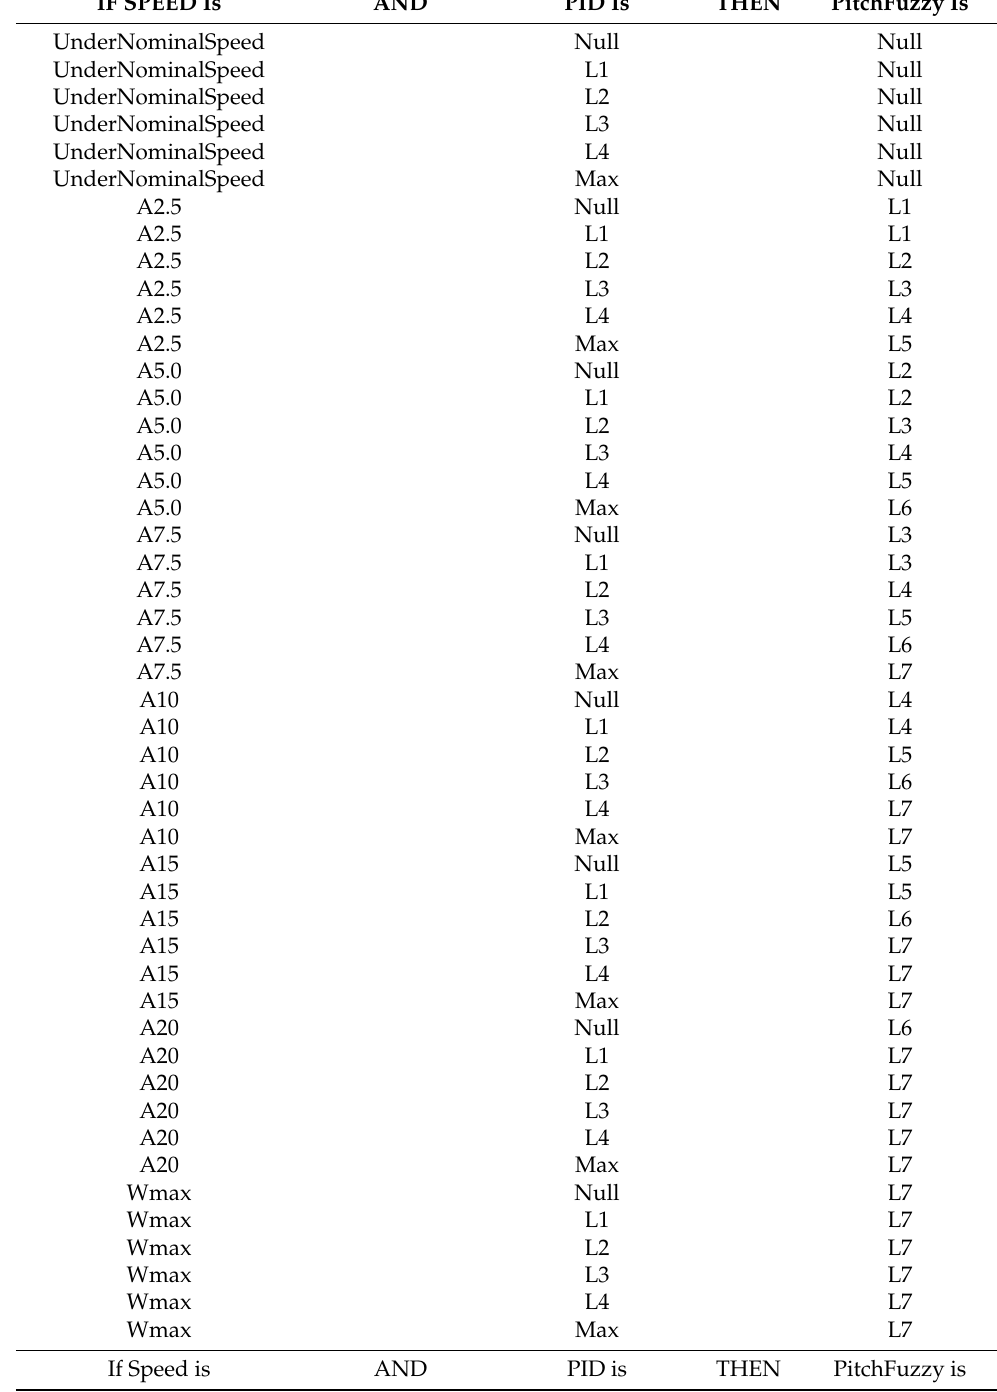
Table 5. Rules of the proposed fuzzy logic controller (Fuzzy A). IF SPEED Is AND PID Is THEN PitchFuzzy Is UnderNominalSpeed Null Null UnderNominalSpeed L1 Null UnderNominalSpeed L2 Null UnderNominalSpeed L3 Null UnderNominalSpeed L4 Null